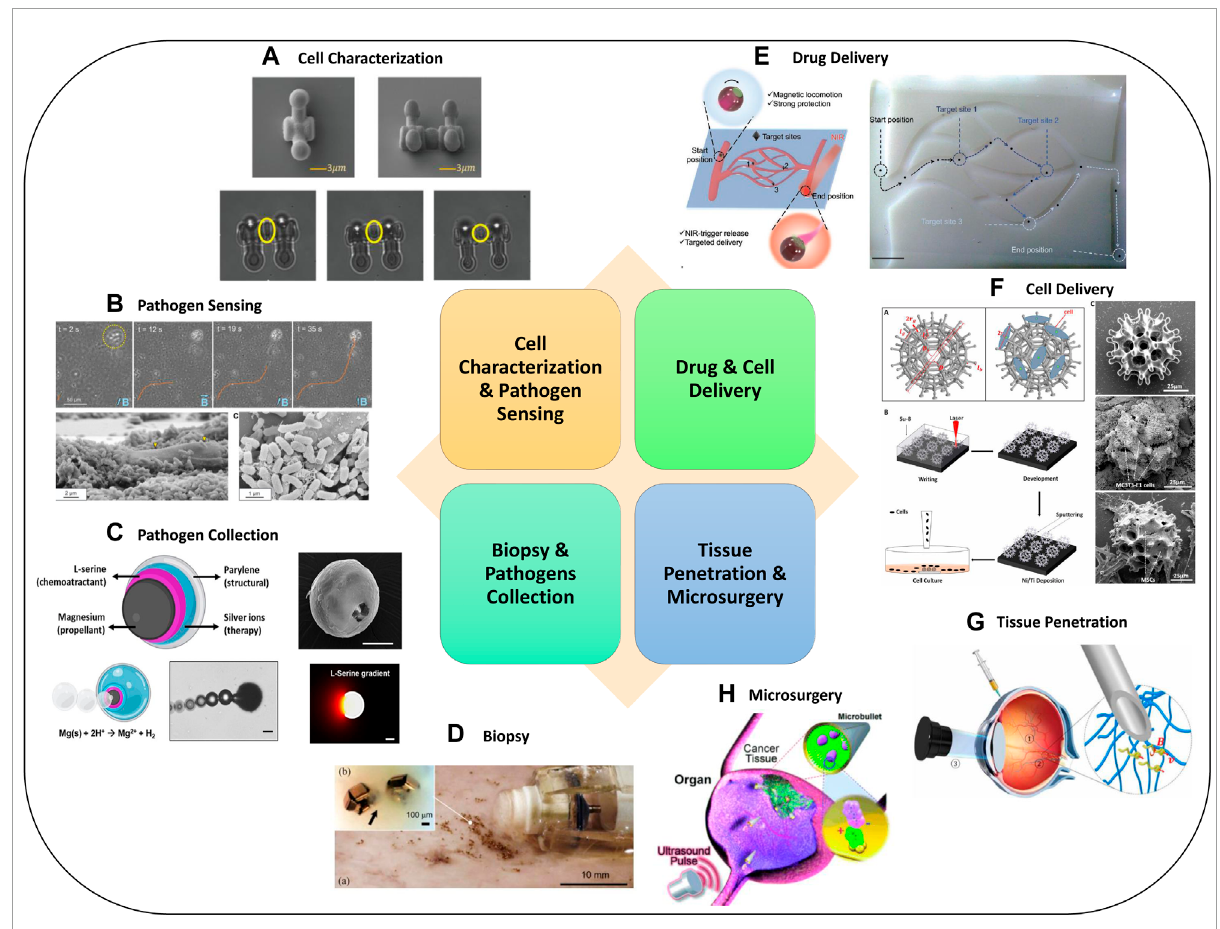
FIGURE 4 Advanced Micro-robotics for biomedical applications. Examples for (A) cell characterization (Zhang et al., 2020d), (B) pathogen sensing (Stanton et al., 2017), (C) pathogen collection (Soto et al., 2020), (D) biopsy (Yim et al., 2014), (E) drug delivery (Song et al., 2022), (F) cell delivery (Li et al., 2018), (G) tissue penetration (Wu et al., 2018), (H) microsurgery (Kagan et al., 2012). Panel (A) reproduced from (Zhang et al., 2020d) under the terms of the CC-BY license. Copyright 2020, The Authors, published by Wiley. Panel (B) reproduced from (Stanton et al., 2017) with permission. Copyright 2017, American Chemical Society. Panel (C) reproduced from (Soto et al., 2020) with permission. Copyright 2020, Wiley. Panel (D) reproduced from (Yim et al., 2014) with permission. Copyright 2014, IEEE. Panel (E) reproduced from (Song et al., 2022) under the terms of the CC-BY license. Copyright 2022, The Authors, published by Wiley. Panel (F) reproduced from (Li et al., 2018) with permission. Copyright 2018, published by The American Association for the Advancement of Science. Panel (G) reproduced from (Wu et al., 2018) under the terms of the CC-BY license. Copyright 2018, The Authors, published by The American Association for the Advancement of Science. Panel (H) reproduced from (Kagan et al., 2012) with permission. Copyright 2012,